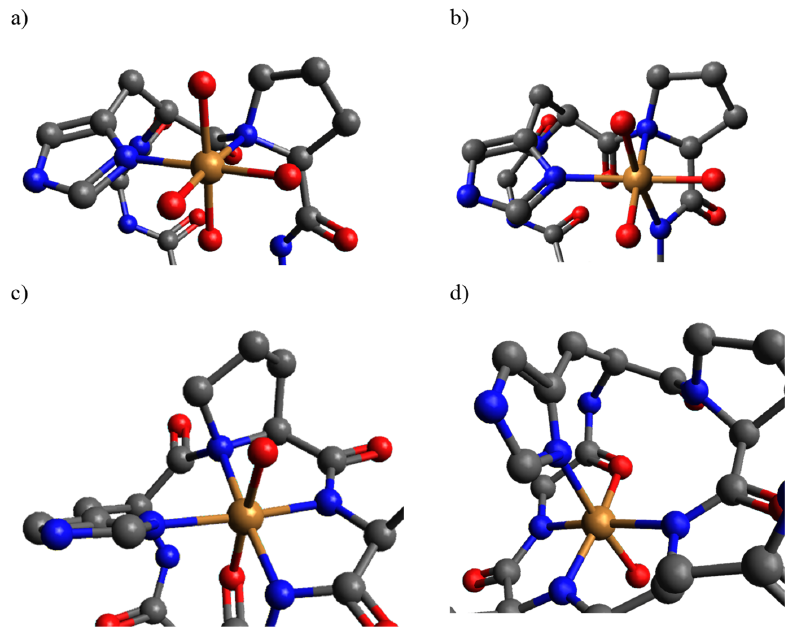
Figure 1. The species distribution curves for the system of L1 − c(GlyHisProHisLys) (solid line) and L2 − c(GlyHisGlyHisLys) (dashed line).